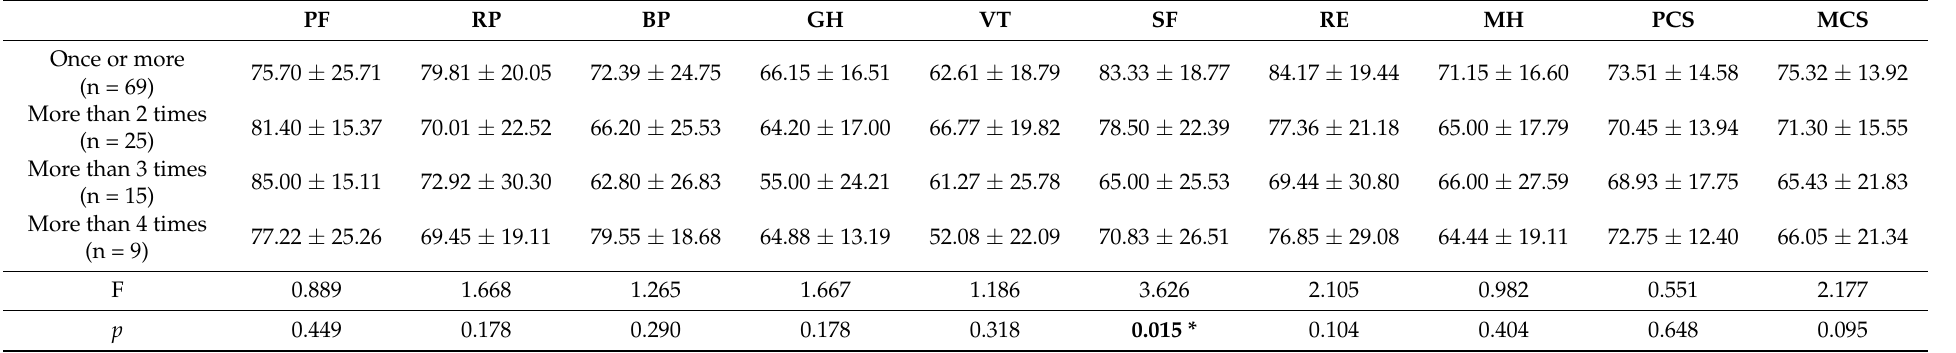
Table 3. Degree of HRQOL depending on the weekly exercise frequency.